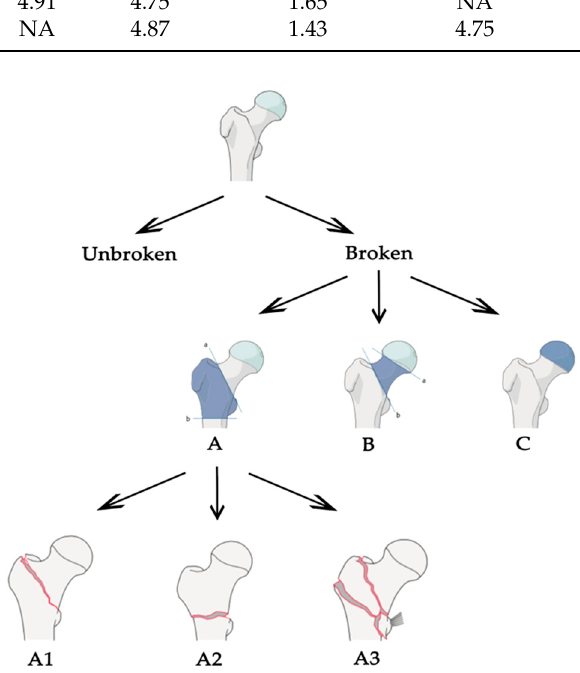
Figure 3. Arbeitsgemeinschaft für Osteosynthesefragen (AO) partial classification for proximal femur fracture.